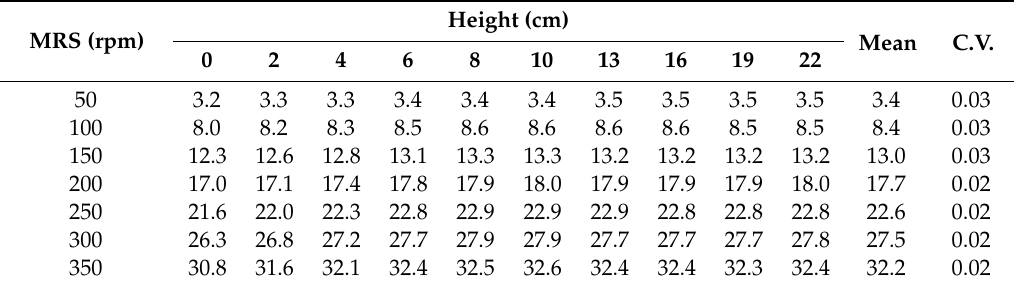
Table 1. Motor rotation speed (MRS) and wind velocity (unit, m / s). MRS